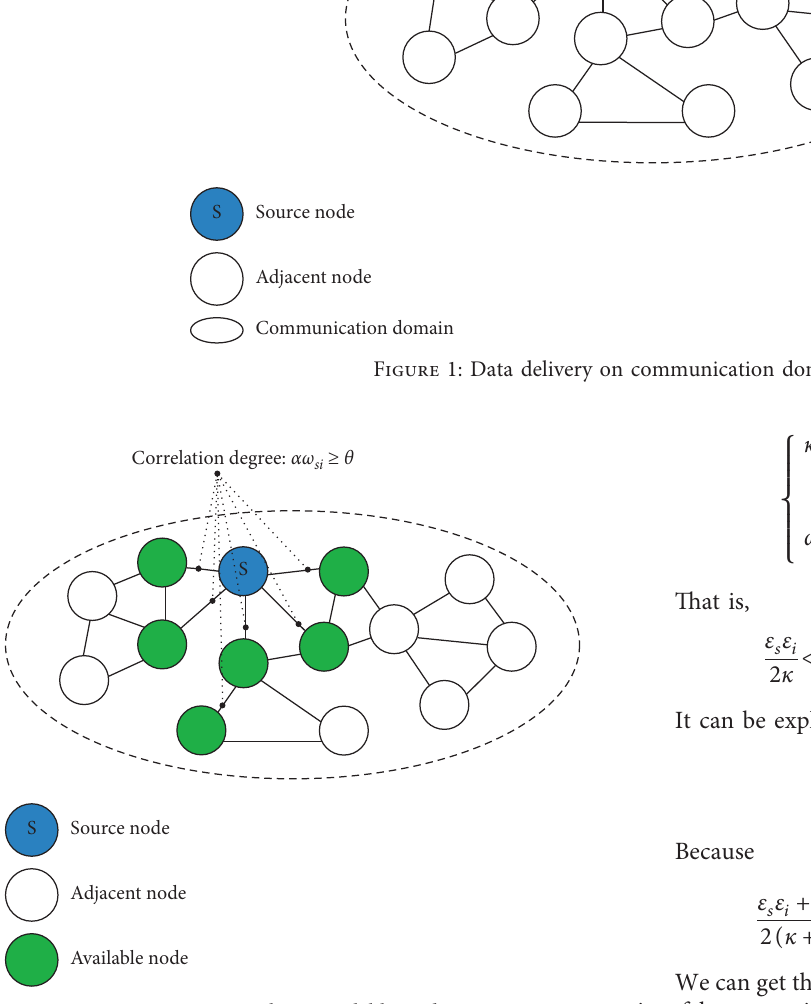
Figure 2: Searching available